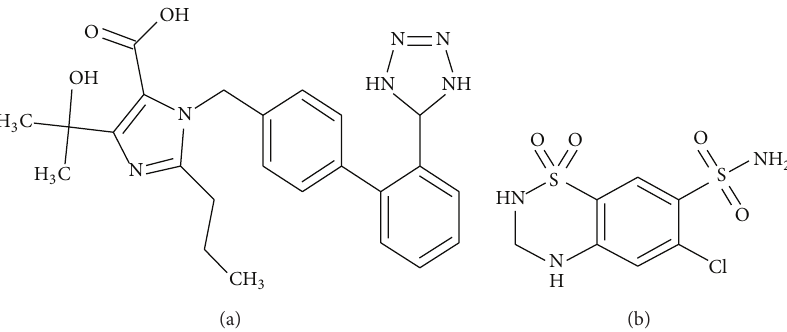
Figure 1: Chemical structure of (a) olmesartan medoxomil (b)